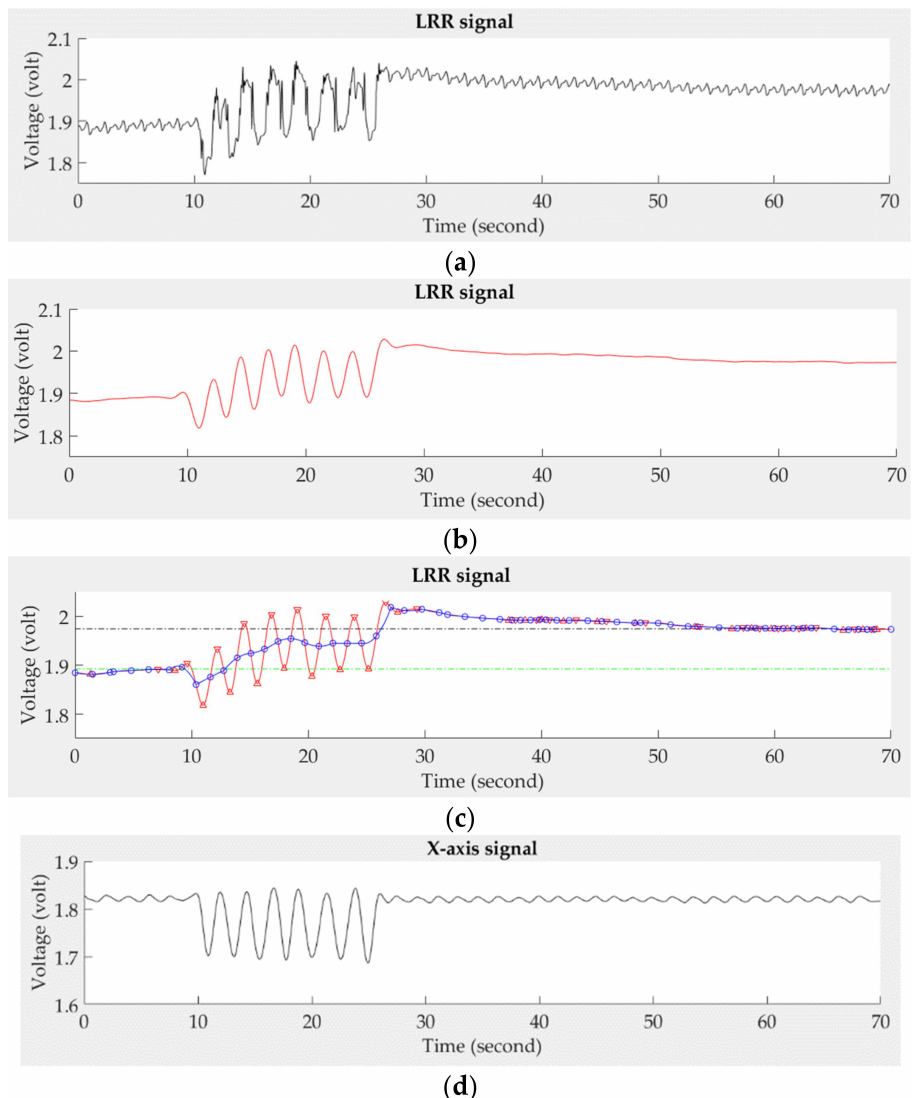
Figure 4. The signal processing steps for a normal LRR signal, ( a ) original signal, ( b ) the filtered signal, ( c ) the smooth (blue line) and filtered (red line) signals, ( d ) the synchronous x -axis